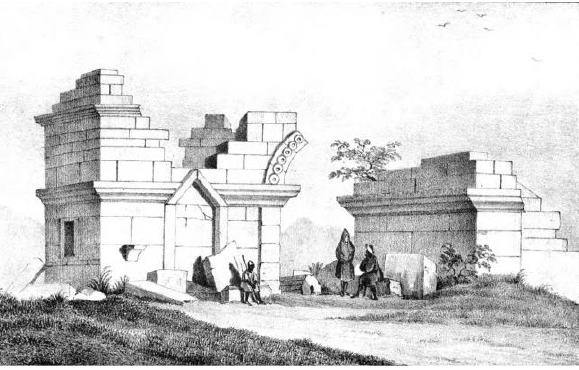
Figure 3. State of the arch in the drawing by F. von Augustin (1823).